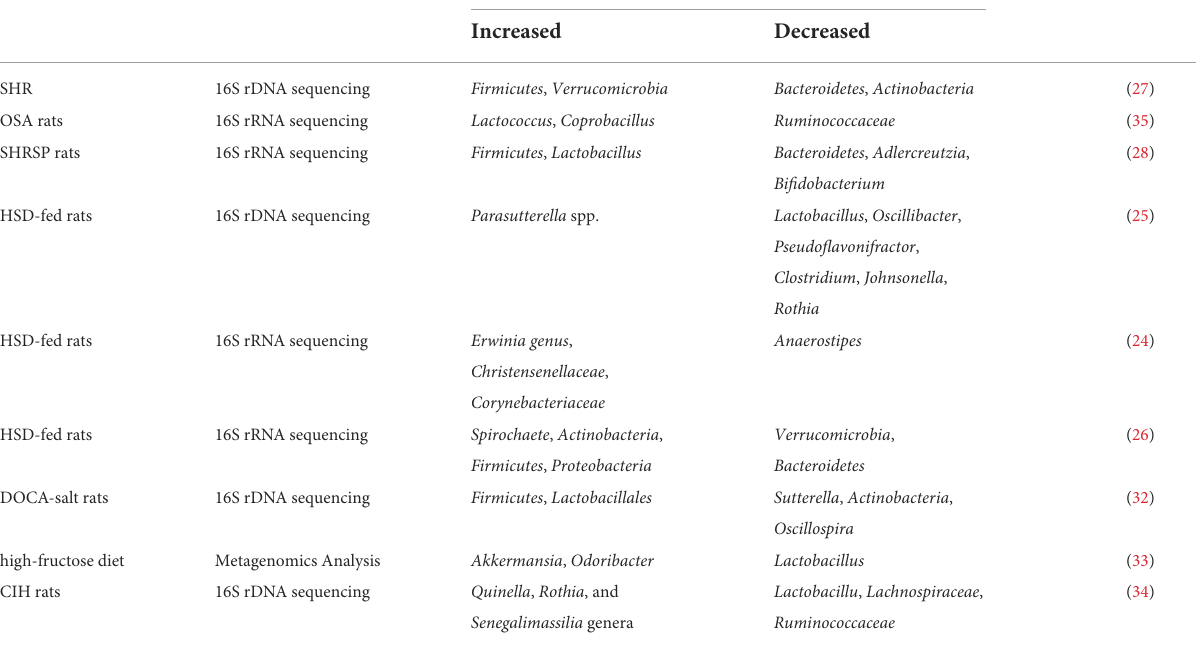
TABLE 1 Composition of intestinal microbiota in hypertensive